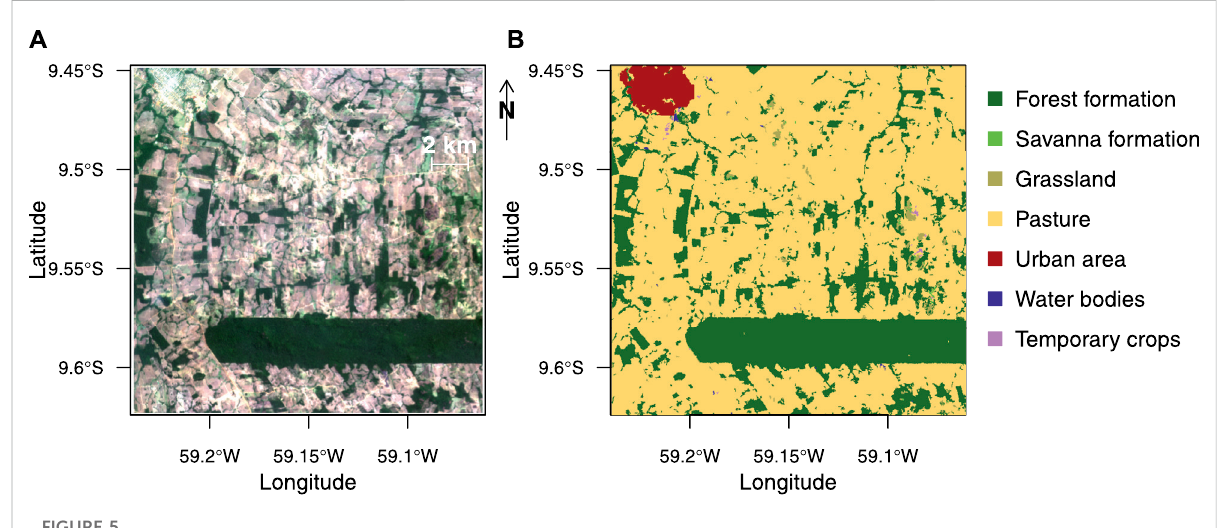
FIGURE 5 Geographical location of the region of interest with RGB composite of the Planet image used in the experiment (A) ; land use/cover classes of the region of interest for the year 2020 from the MapBiomas project (B)